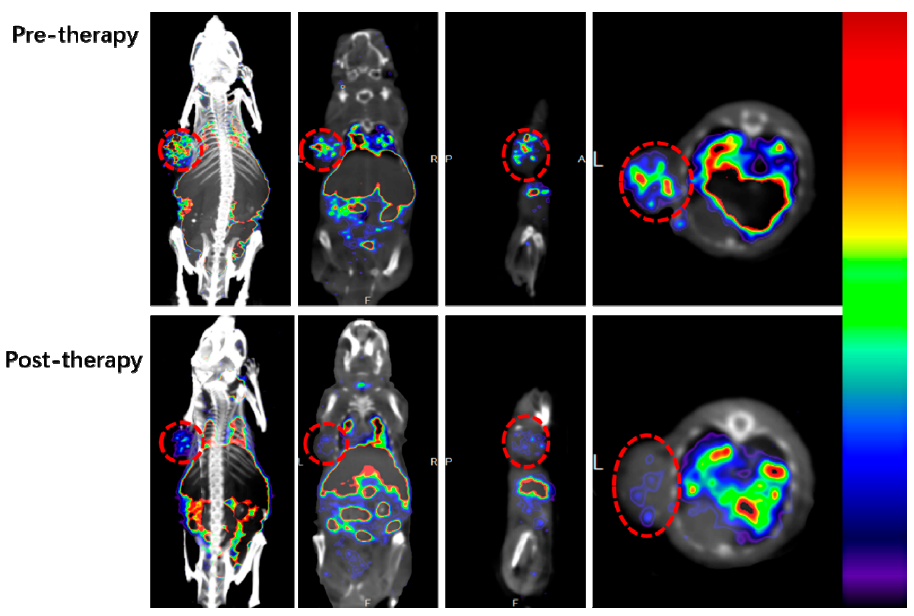
Figure 4. Maximum Intensity Projection (MIP) images and its axial, transverse and sagittal images demonstrate that 99m Tc-bevacizumab uptake in tumor are less than pre-therapy.